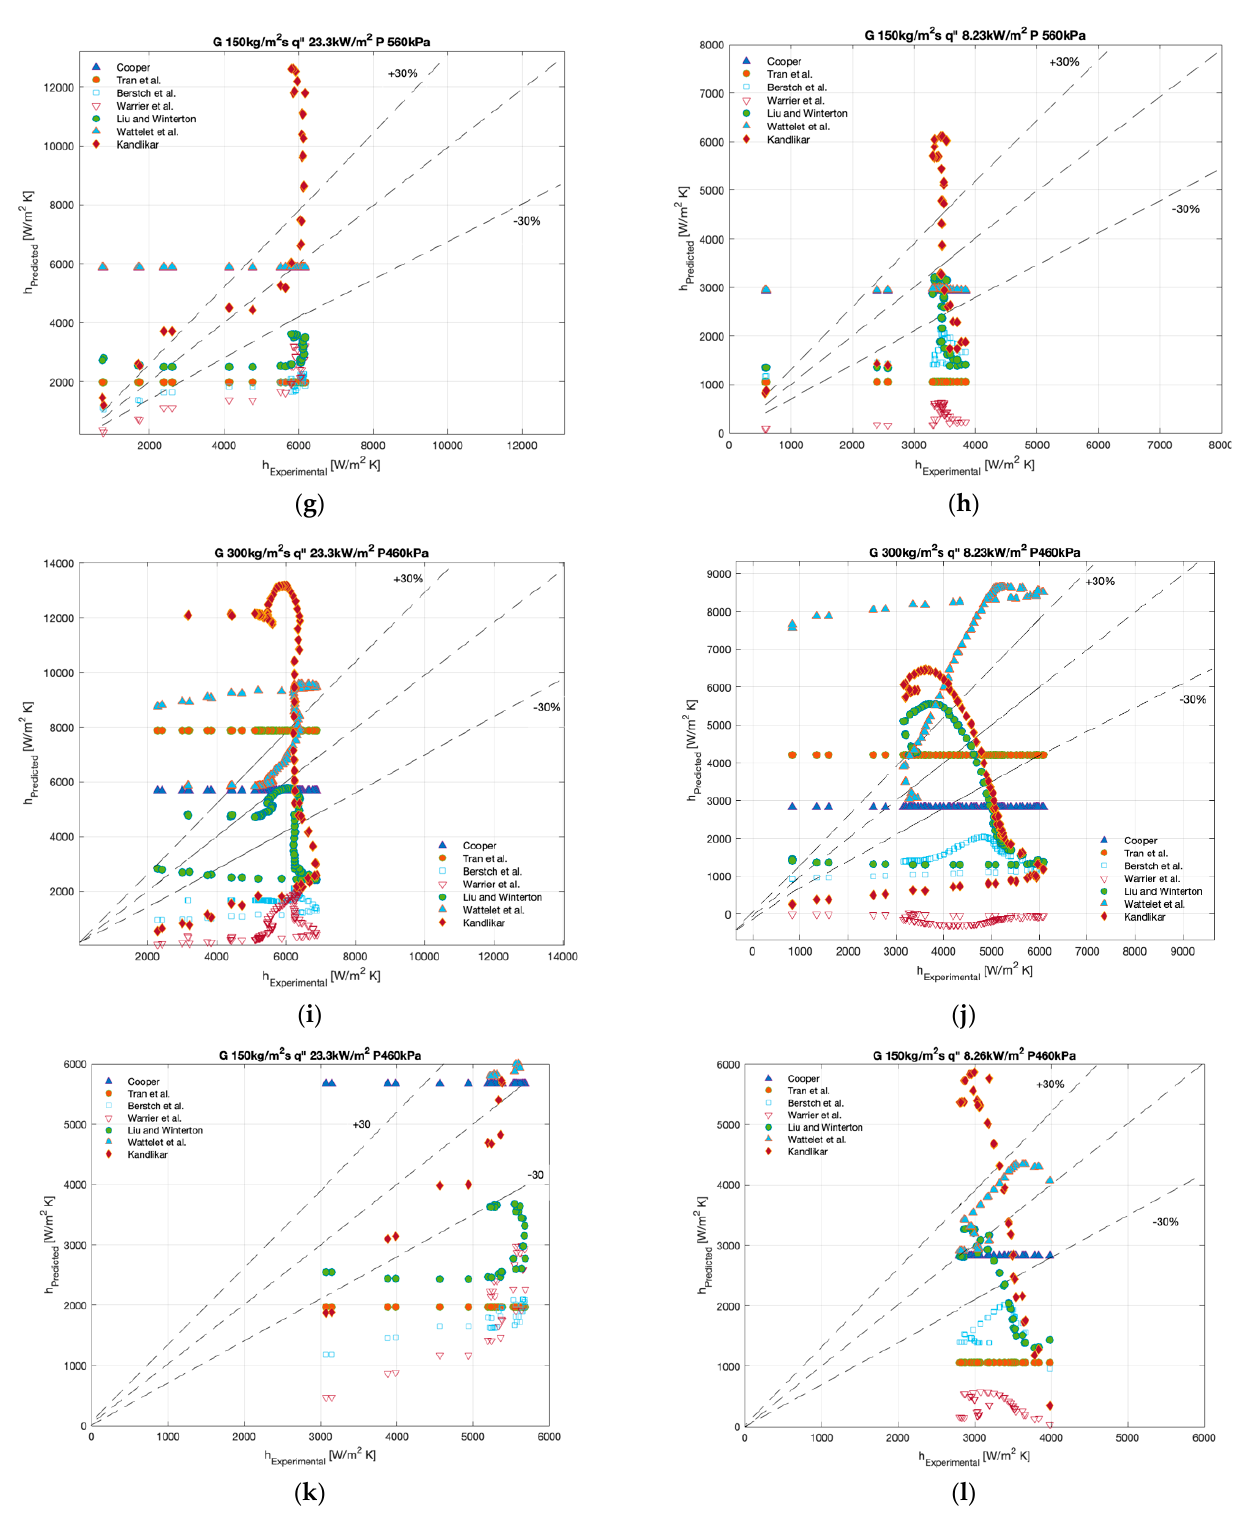
Figure 11. ( a – l ) Comparison between each experimental result measured at conditions of G 150–300 kg/m 2 s, q ″ 8.26–23.3 kW/m 2 , P 460–660 kPa and the calculated heat transfer coefficient developed